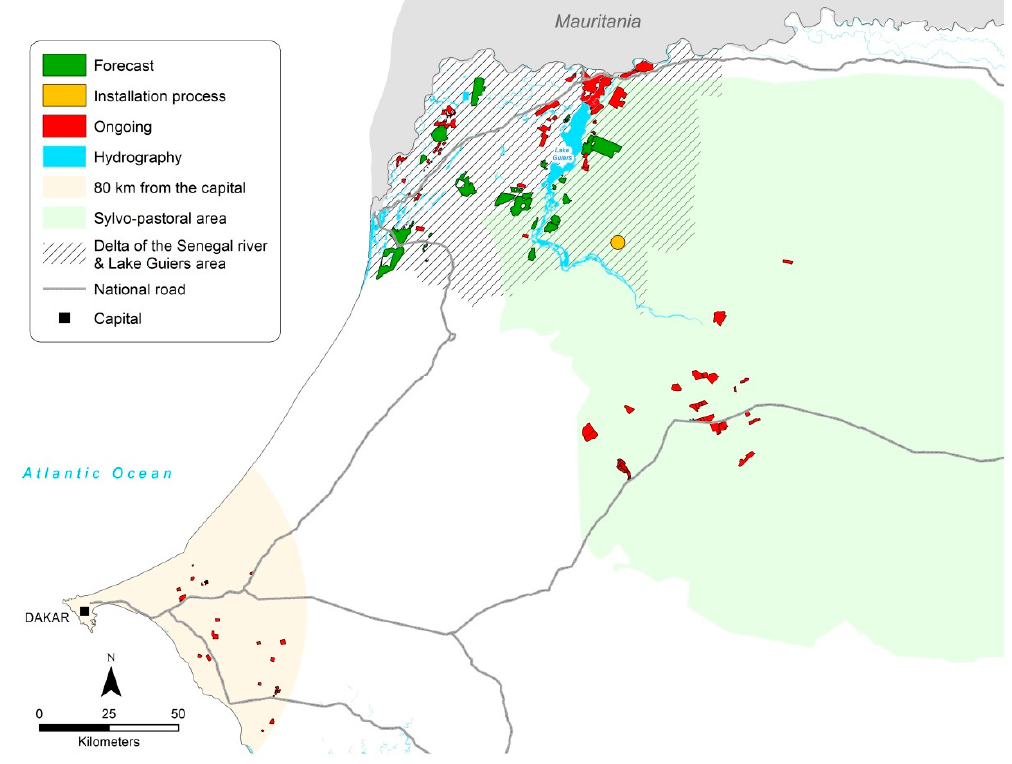
Figure 7. Identification of agro-industrial farms in three main hotspots.